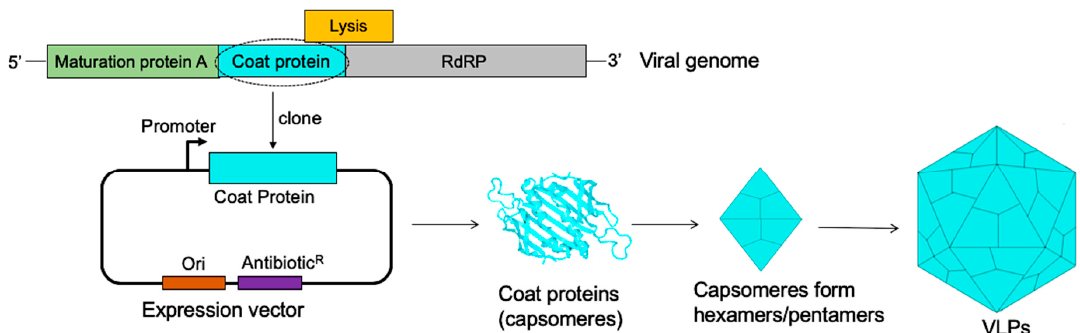
Figure 1. The assembly of bacteriophage MS2 coat proteins into VLPs (virus ‐ like particles). The genome of MS2 bacteriophage (top image) with the coat protein (light blue). Cloning of the coat protein into a bacterial expression vector and expression of the protein in a suitable bacterial host gives rise to coat proteins (capsomers). The capsomeres form pentamers and hexamers; twelve pentamers and 20 hexamers spontaneously self ‐ assemble to form a VLP (composed of 180 capsomeres). RdRP stands for RNA dependent RNA